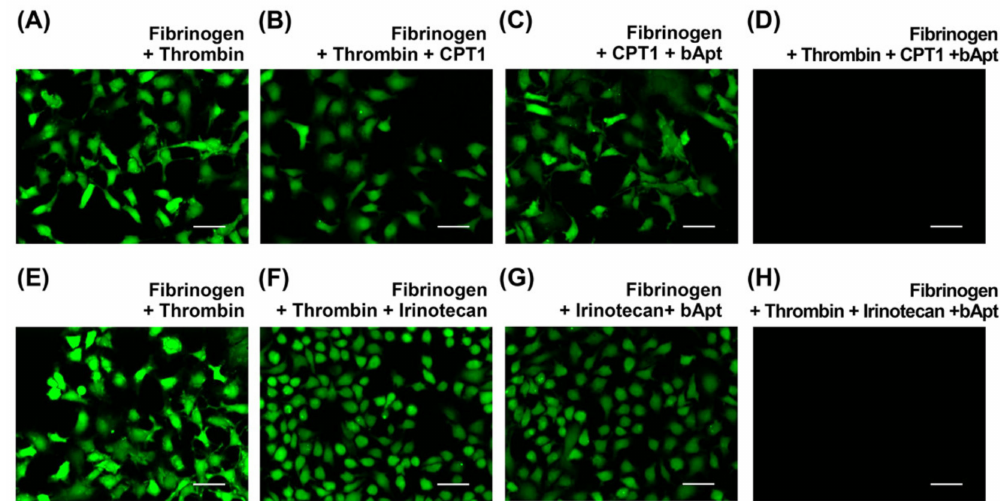
Figure 4. Fluorescence microscopy images of the HeLa cells incubated for 48 h at 37 ◦ C after addition of ( A , E ) fibrinogen and thrombin, ( B , F ) fibrinogen, thrombin and CPT1 or irinotecan, ( C , G ) fibrinogen, CPT1 or irinotecan, and bApt, and ( D , H ) fibrinogen, thrombin, CPT1 or irinotecan, and bApt. Thethrombin, CPT1oririnotecan, andbAptconcentrationsare100nMeachandfibrinogenconcentration is 1000 nM. Scale bar = 50 µ